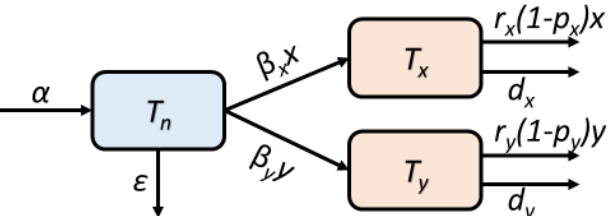
Figure 2. The T-cell regulatory pathway, which involves the naïve T-cells, is denoted T n . The baseline production rate is denoted α and natural elimination rate (cid:101) . The pathogen specific cytotoxic T-cells are produced from this T-cell regulatory pathway. The amount of cancer cells is denoted by x , while that of infected cells is denoted by y . The amount of the cancer specific effector cells is denoted T x and is produced with the per capita rate β x x while the amount of the infection specific effector cells is denoted T y and is produced with the per capita rate β y y . The effector cells have natural death rates d x and d y , respectively. In addition, active cytotoxic T-cells may become inactivated or exhausted, which adds an extra removal from the pools of active cytotoxic T-cells. The removal per time is assumed proportional to the respective binding with cancer cells and infected cells multiplied by the probabilities 1 − p x and 1 − p y ,